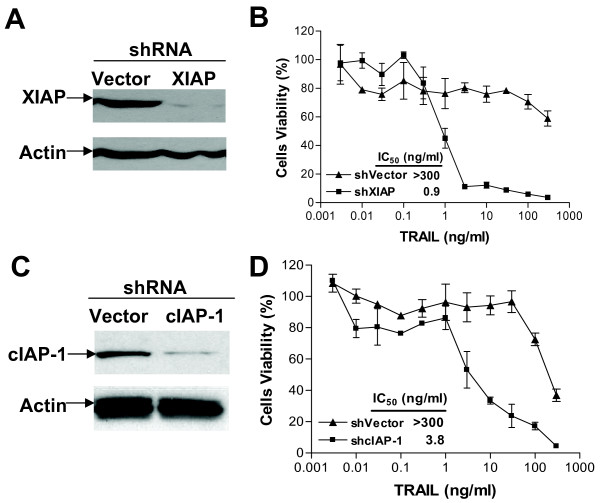
Downregulation of XIAP or cIAP-1 sensitized TRAIL-induced cell death. DU145 cells were transfected with shRNA of XIAP (shXIAP) (A, B) or cIAP-1 (shcIAP-1) (C, D), or the vector control (shVector), and knockdown effect was measured 48 h after transfection (A, C). Transfected cells were treated with TRAIL, and cytotoxicity was determined by CCK-8 detection kit (B, D). Normalized data were presented as mean ± SD (n = 3).